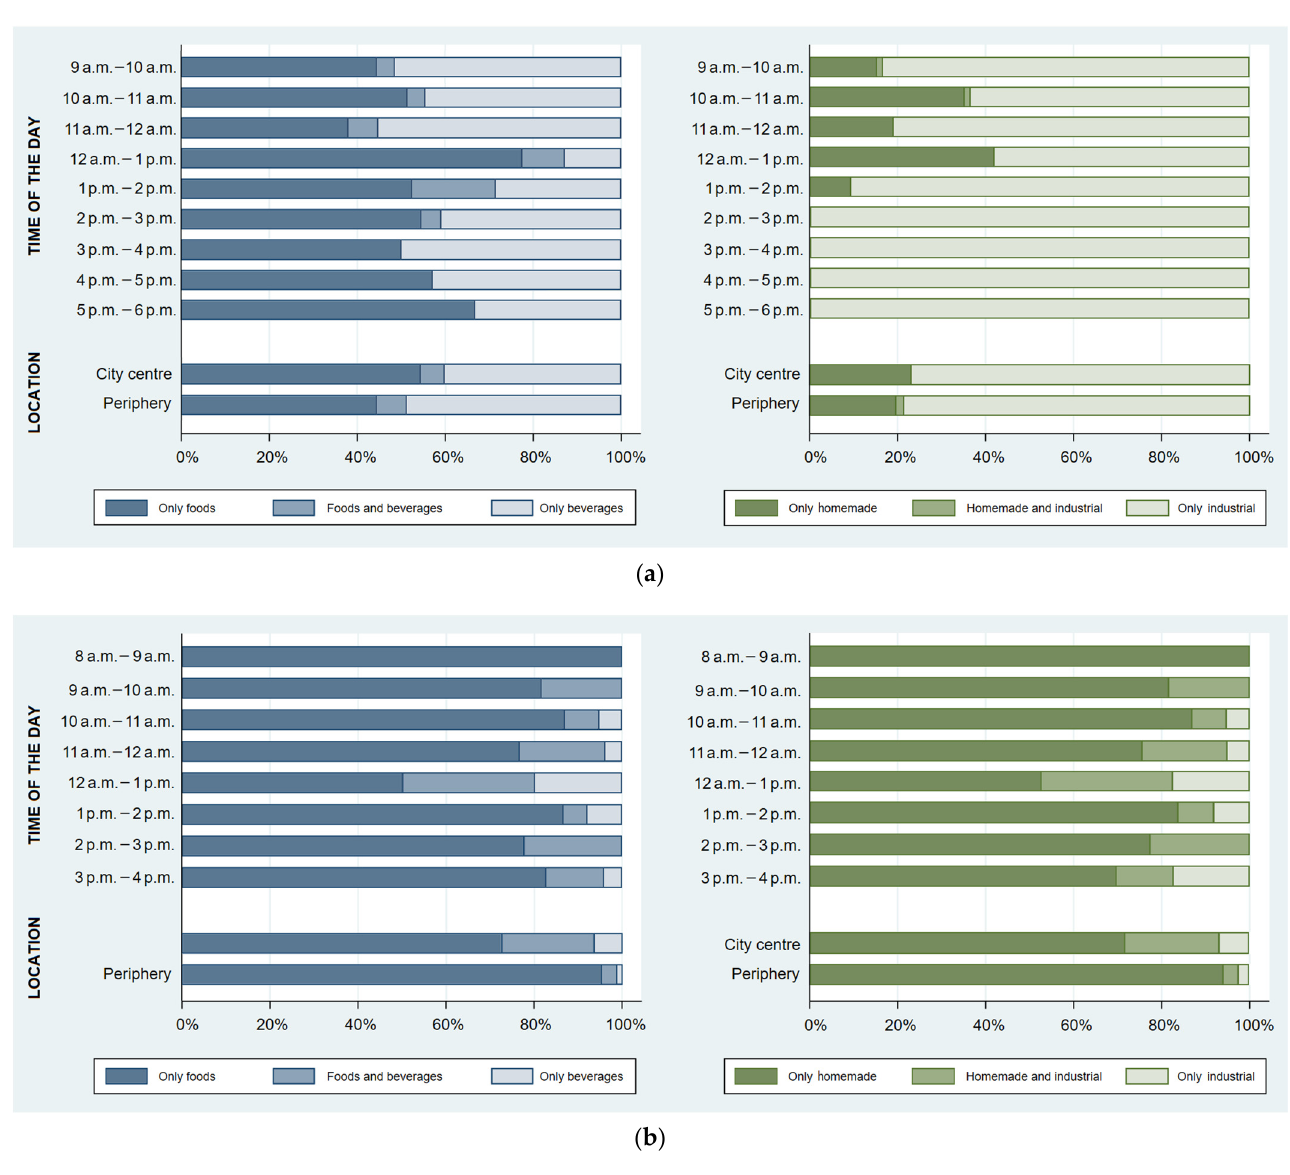
Figure 3. Proportion of customers purchasing foods and/or beverages and homemade and/or industrial food items, in the ( a ) street food and ( b ) takeaway food vending sites observed, throughout the day and by city location (street food: n = 298 purchases; takeaway: n = 457 purchases).